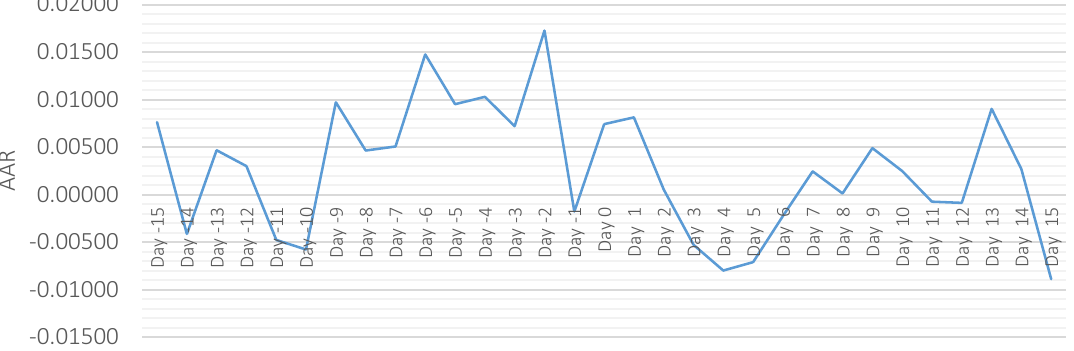
Figure 3. Average Abnormal Returns (AAR) for IT and Telecom Sector